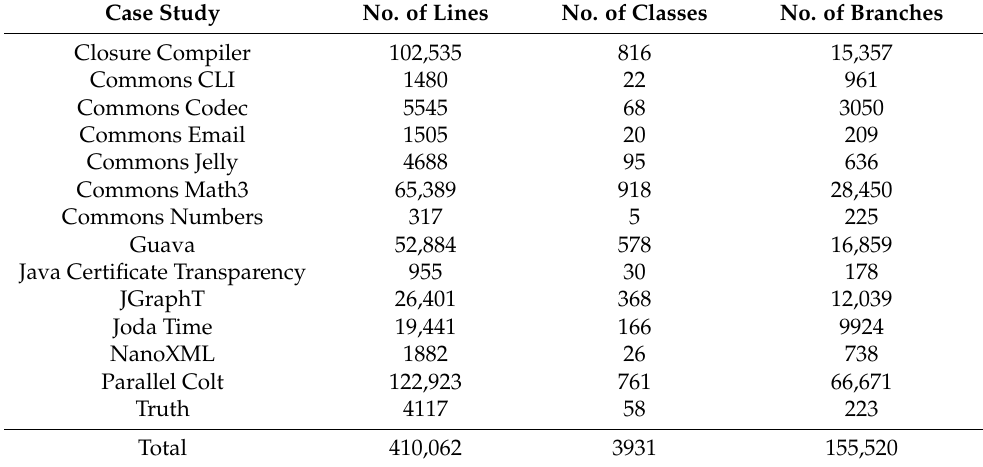
Table 1. Detail of tested